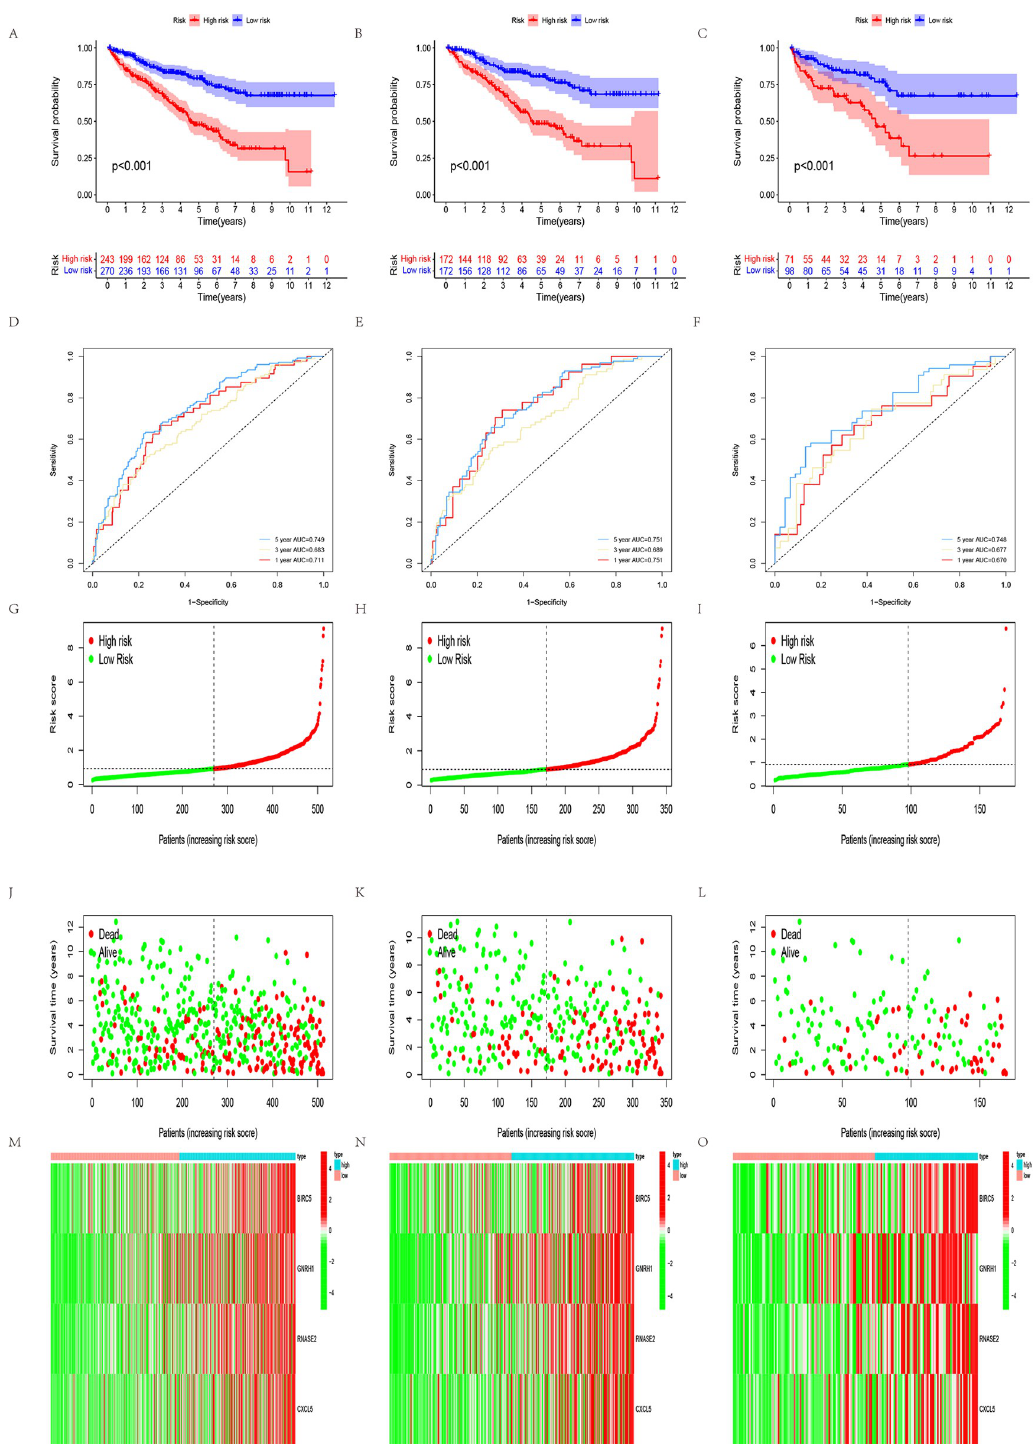
Fig 4. Survival models and internal validation of prognostic IRGPI for all patients with ccRCC, training and test groups, and correlation between risk scores and clinical traits. (A–C) Three groups of patients had good prognoses in the low-risk group, respectively. (D–F) ROC curves of the prognostic survival model of the three groups. (G–I) Risk score of the high- and low-risk groups in the three groups. (J–L) survival time and status of patients in the three groups. (M–O) Heat map of the four hub genes between the high- and low-risk